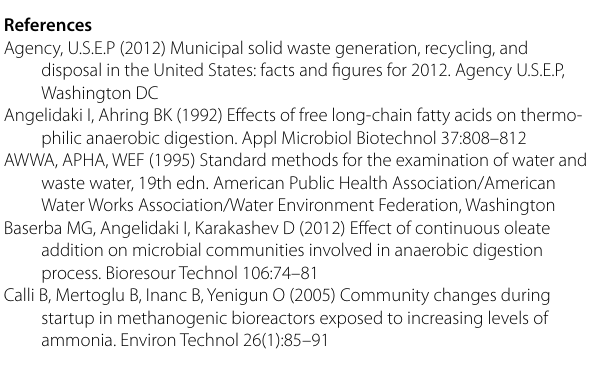
were also found to increase up to 40% with OLR eleva- tion. The effects of OLR on the bacterial community dynamics were found to be highly significant, as com- pared with that on the archaeal communities.